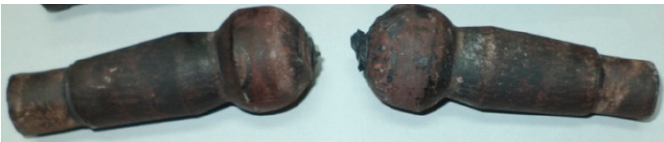
Figure 5. Ball studs after cutting during cross-wedge rolling (CWR).